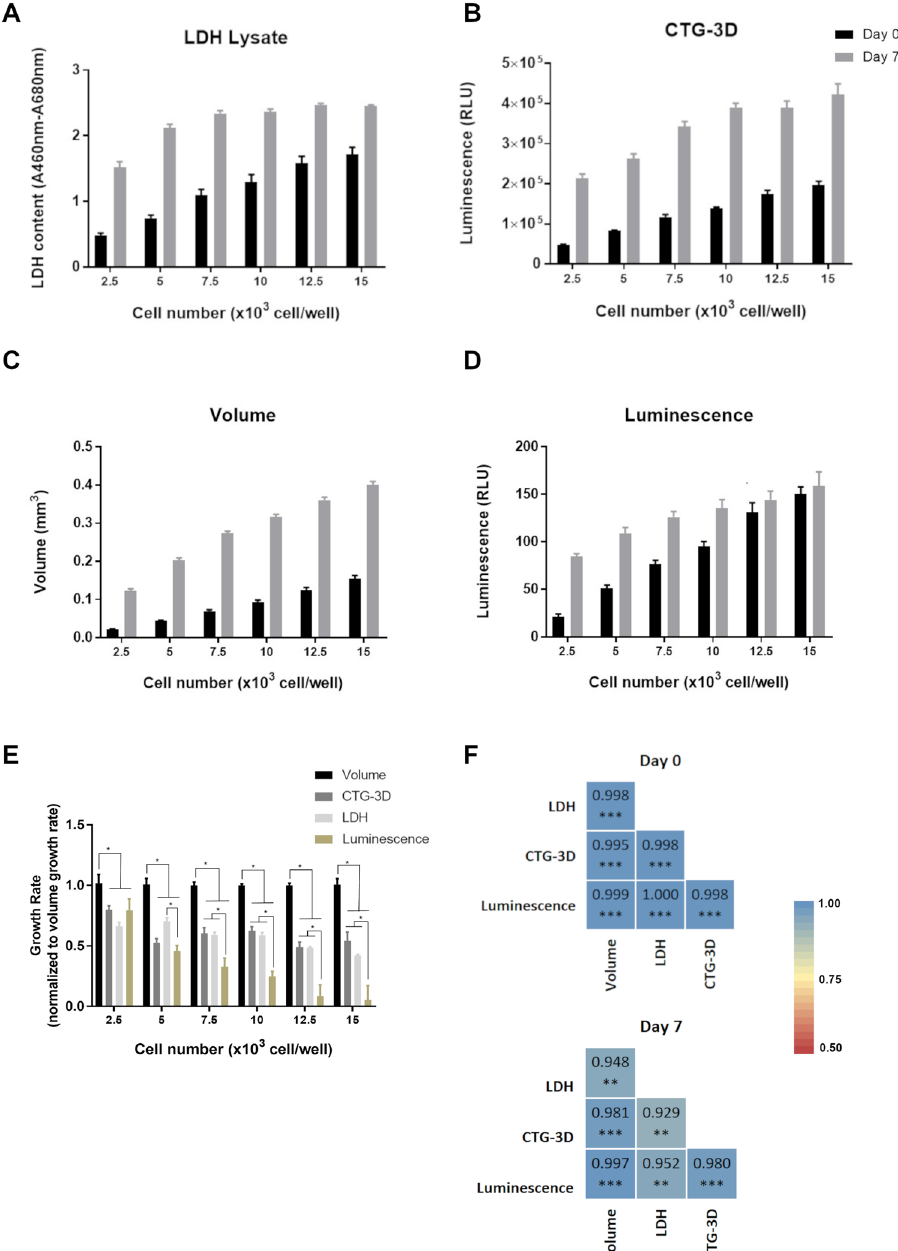
Figure 1. LDH assay reproducibility and precision in 3D culture is equivalent to alternate readout methods. ( A ) Lactate dehydrogenase (LDH) content, ( B ) CellTiter-Glo 3D (CTG-3D), ( C ) volume, and ( D ) luminescence measurements were collected from NCI-H1650 and/or NCI-H1650.LMC spheroids generated by seeding 2500, 5000, 7500, 10,000, and 12,500 cells per well of ultra-low attachment round bottom plates. LDH content and volume measurements were collected from both NCI-H1650 and NCI-H1650.LMC spheroids, CTG-3D readings were collected from NCI-H1650 spheroids only, and luminescence readings were collected from NCI- H1650.LMC spheroids only. Statistics for data presented in ( A – D ) is summarized in Supplementary Tables 1–3. ( E ) Growth rates for each seeding density condition calculated from cell content determined by each readout method was normalized to the growth rate determined from volume measurements. ( F ) Pearson correlation coefficient between volume and LDH, CTG-3D, and luminescence measurements (data are presented as mean ± SD of N = 5, * p < 0.05, ** p < 0.01, *** p <